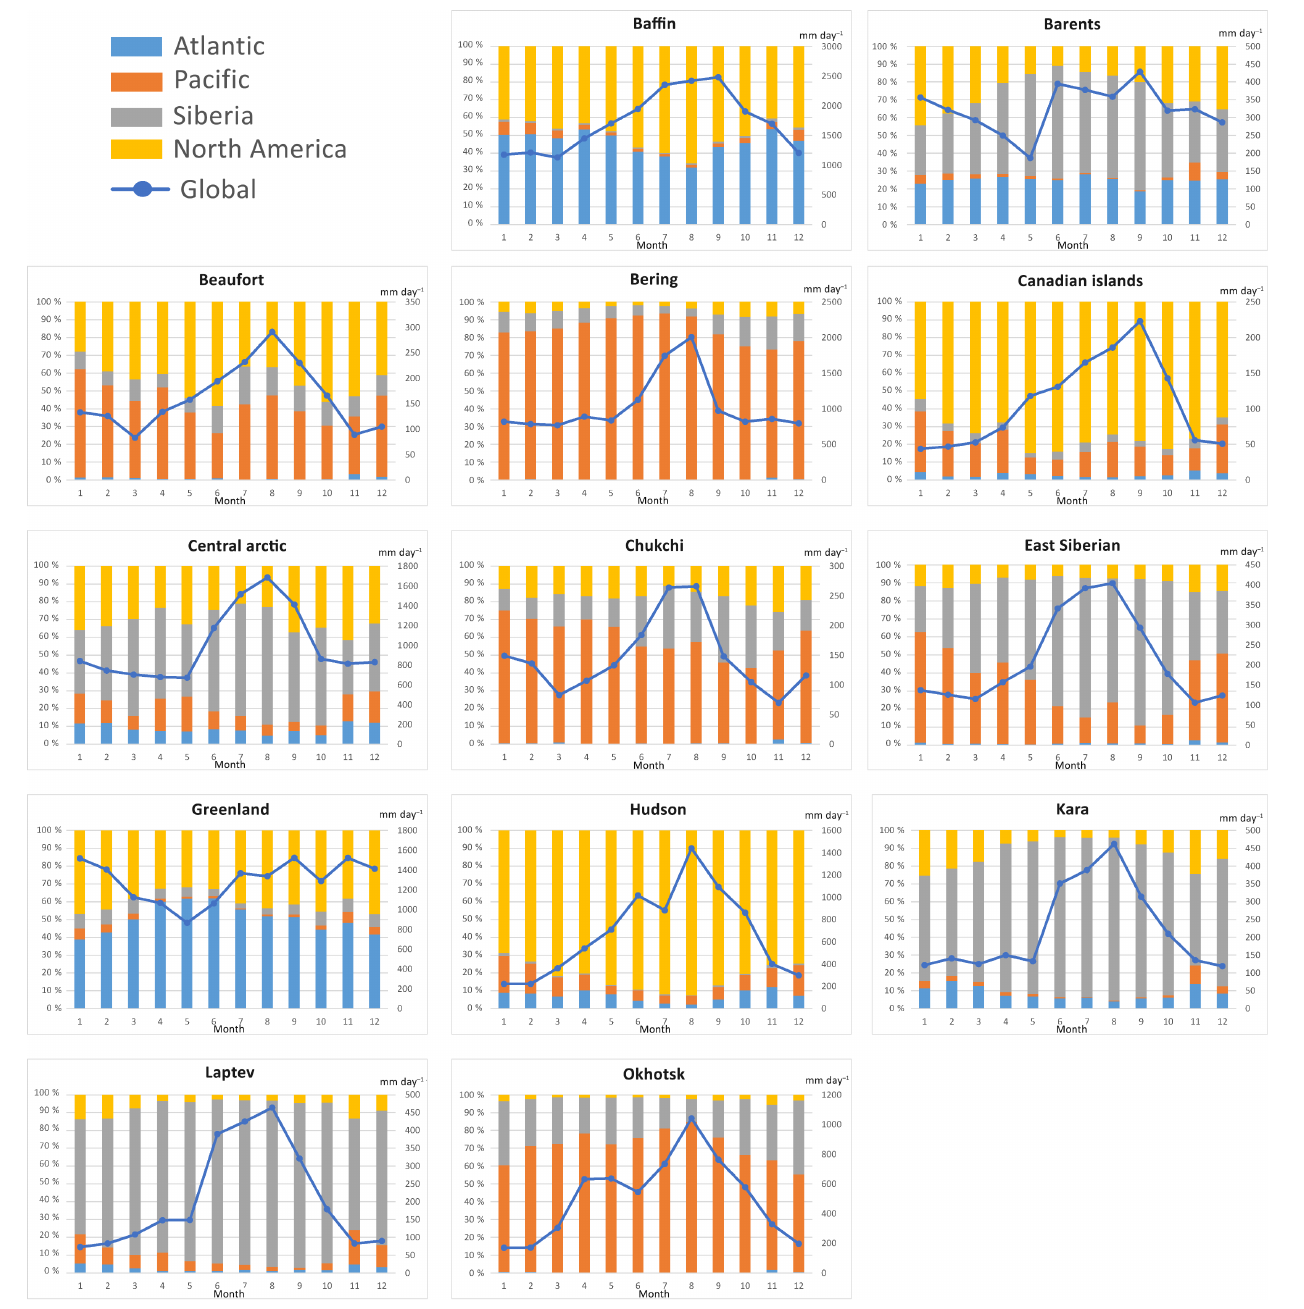
Figure 5. Same as in Fig. 3 but for each of the 13 subregions of the Arctic Ocean